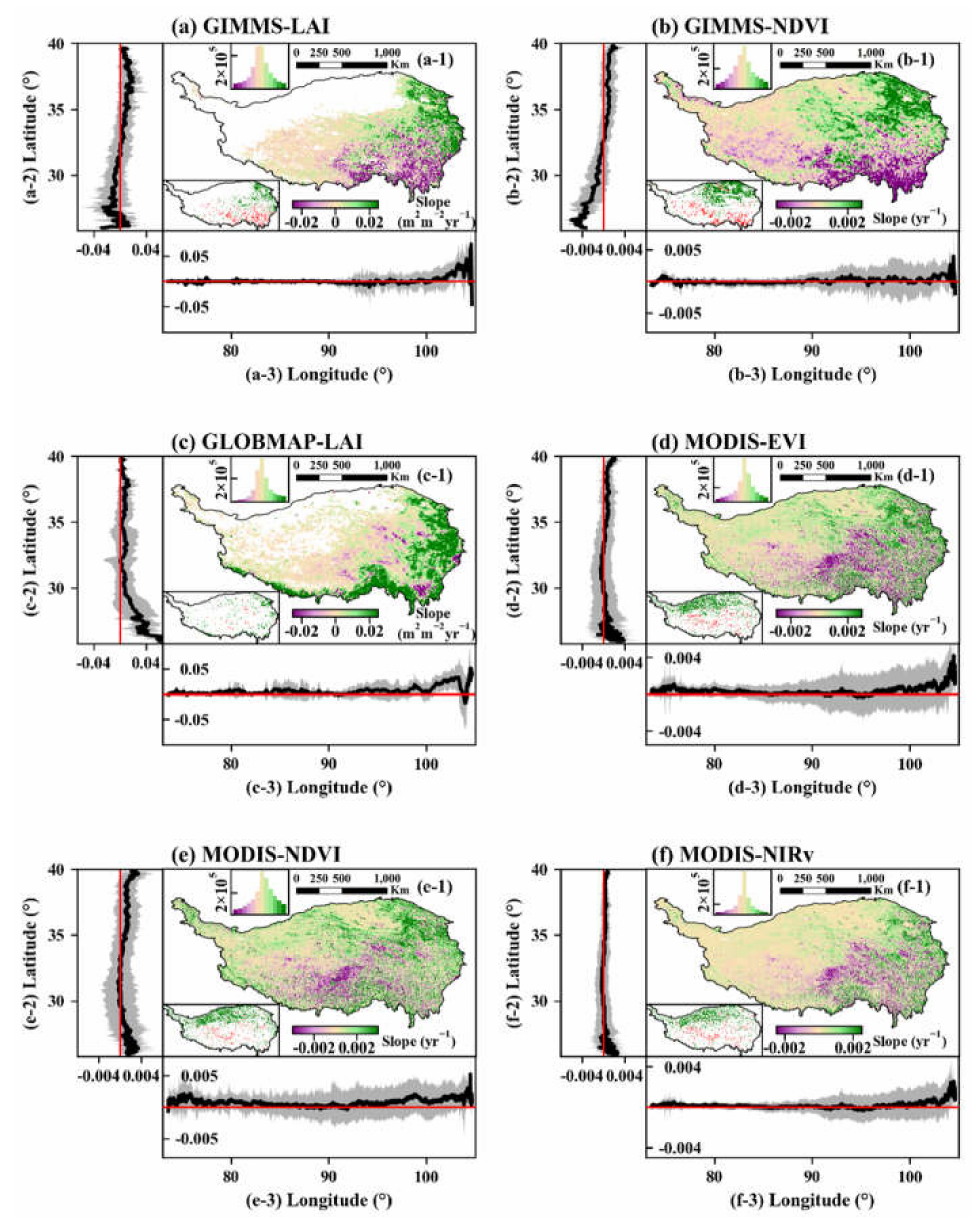
Figure 6. Spatial pattern of the VIs slope in the QTP from 2001 to 2016 ( e-1 – f-1 ). The significance inset of the trend is in the lower-left and the value frequency inset is in the upper-left of each main figure. The subfigures ( e-2 – f-2 ) and ( e-3 – f-3 ) denote the latitudinal and longitudinal distribution of the VIs slope; the shadow regions represent one standard